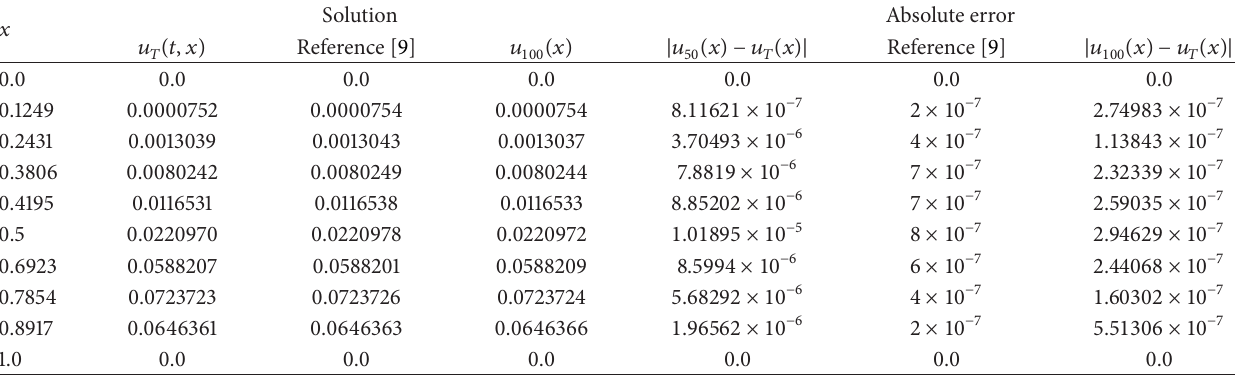
Table 2: Comparison of the absolute error of Example 13.